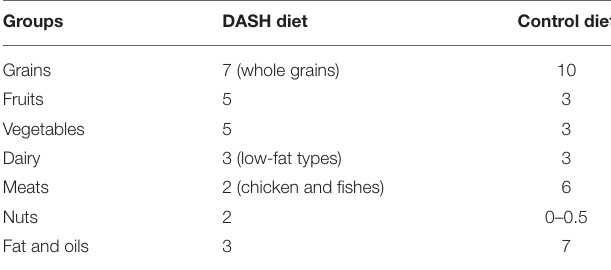
TABLE 1 | Daily food groups serving sizes for diabetic patients on a 2,000-kcal diet.